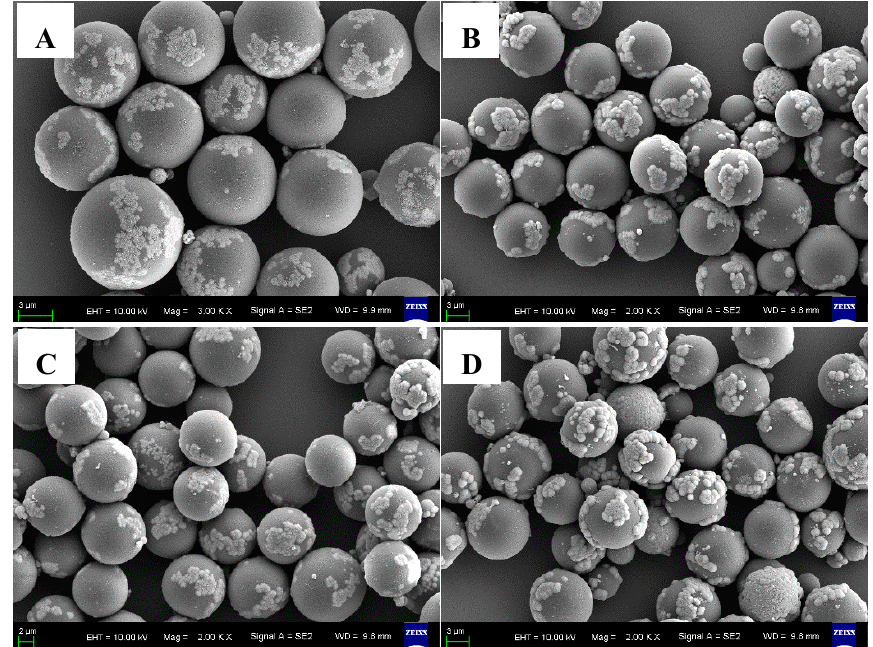
Figure 5. SEM images of the C / Fe 3 O 4 composite microspheres: MC-1 ( A ); MC-2 ( B ); MC-3 ( C ); MC-4 ( D ).